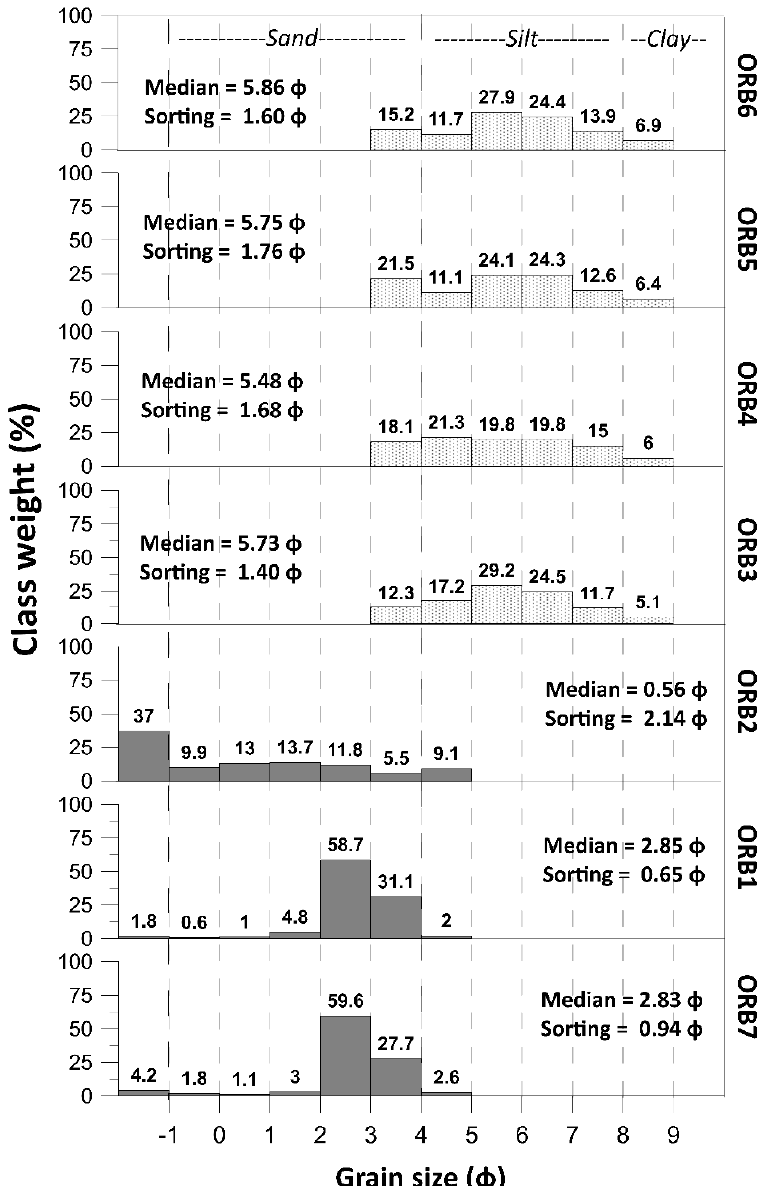
Figure 5. Grain size distribution and classification of the samples. Classification and statistics are obtained through GRADISTAT Microsoft Excel spreadsheet [66].